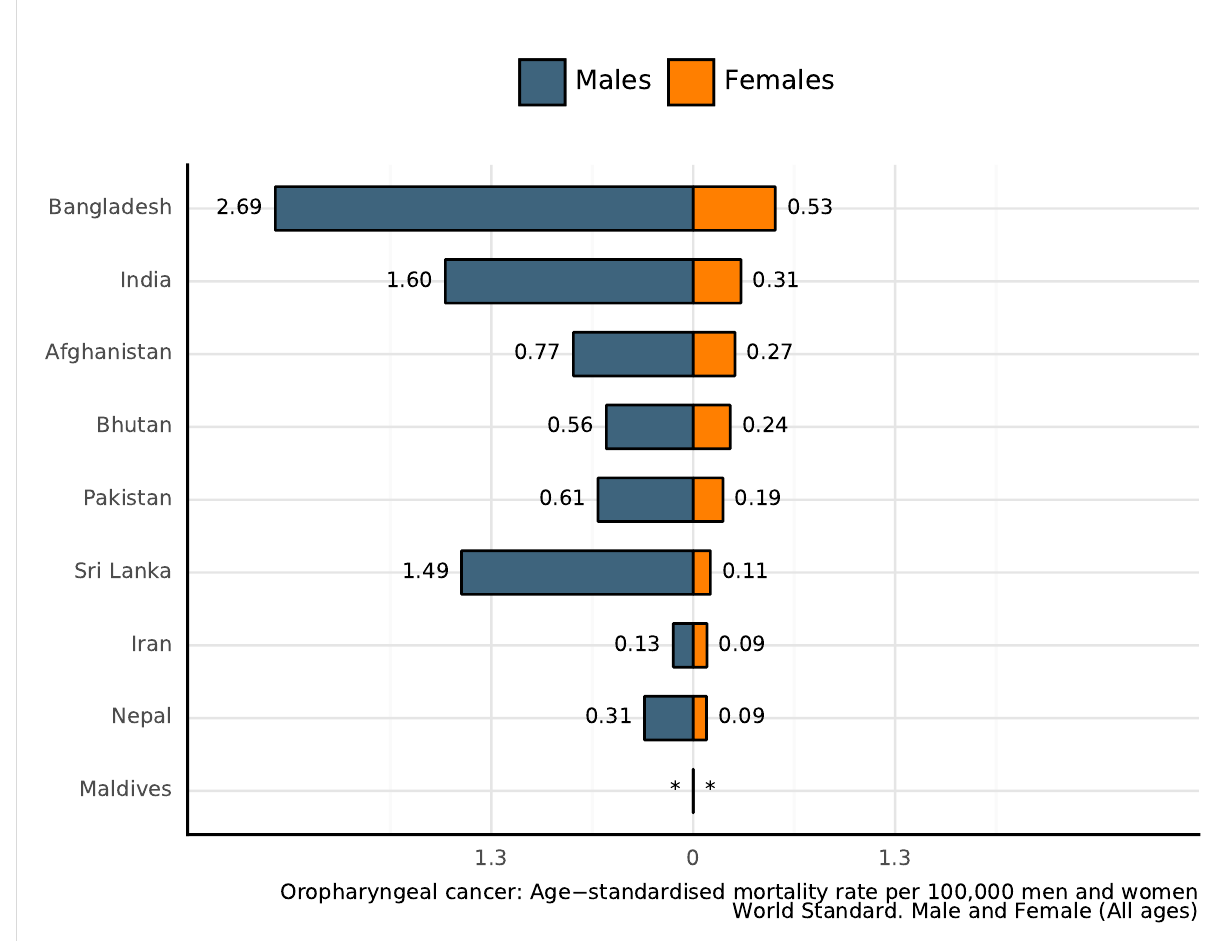
Figure 122: Age-standardised mortality rates of oropharyngeal cancer of India (estimates for 2020)